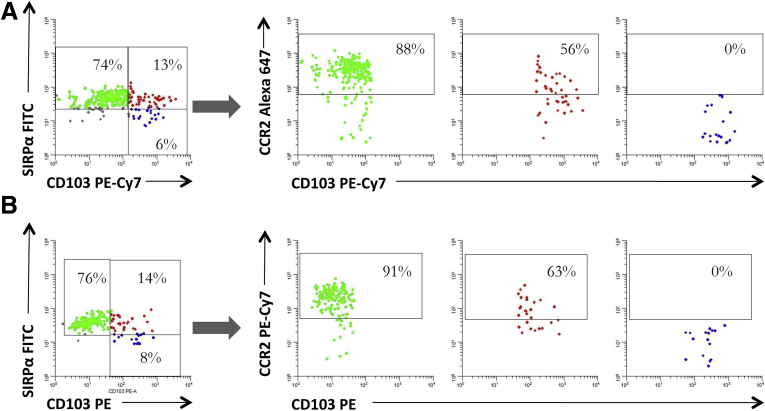
Dendritic cells (DC) were identified as inFigure 1A and divided into subsets based on expression of CD103 and SIRPα. Chemokine (C-C motif) receptor 2 (CCR2) expression was determined in each DC subset using two different clones labeled with different fluorochromes: (A) clone 48607 labeled in Alexa 647 and (B) clone K036C2 labeled in PE-Cy7. The results are representative of two independent experiments performed with similar results.